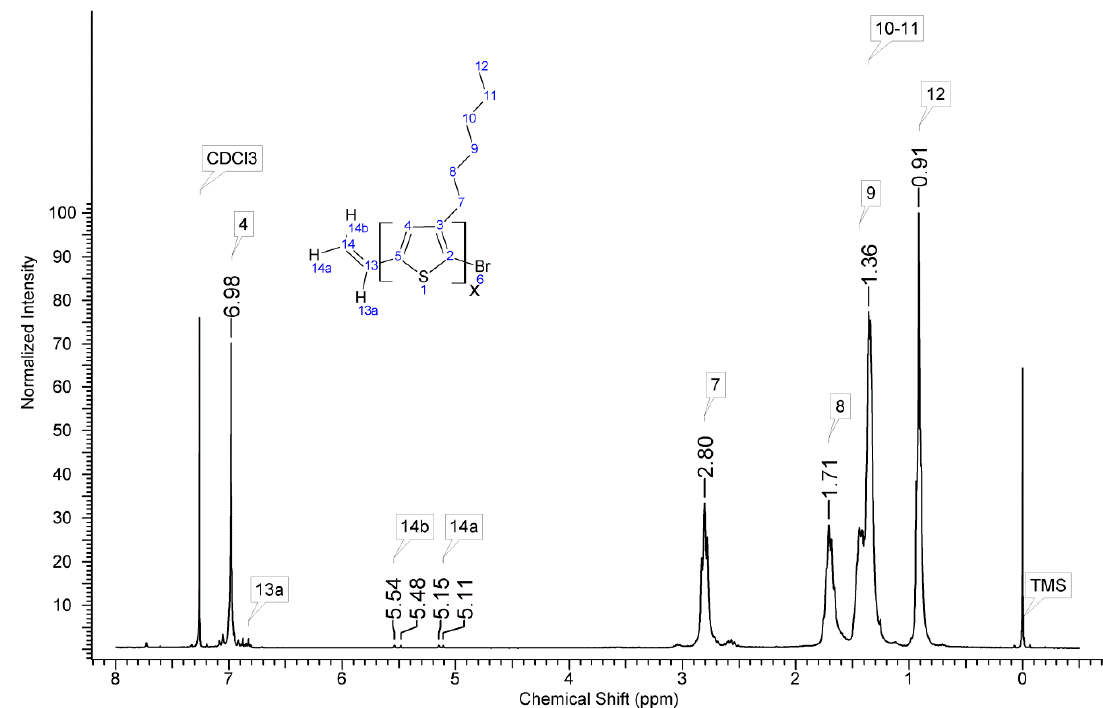
Figure A1. 1 H-NMR spectrum of vinyl-terminated regioregular P3HT (P3HTvin).